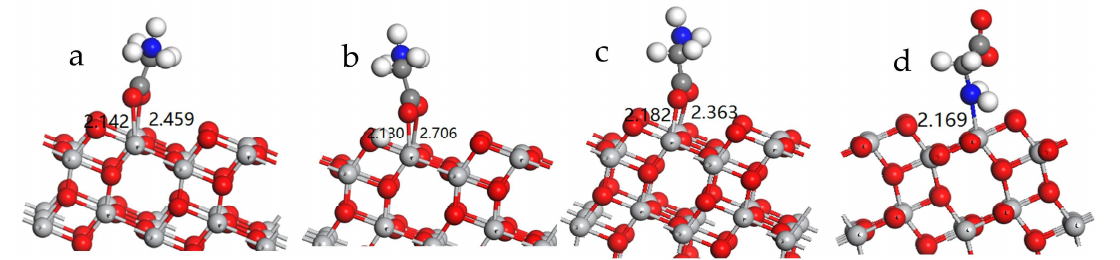
Figure 9. Adsorption model of three dissociated forms of glycine on anatase (TiO 2 ) with (101) facets: ( a ) zwitterionic –COO – ; ( b ) positive dissociated ions of –COOH; ( c ) negative dissociated ions of –COO – ; ( d ) negative dissociated ions of –NH 2 .